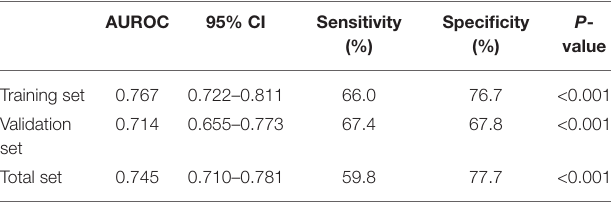
TABLE 4 | Performance of the model for identifying moderate to severe inflammation in the training set ( n = 430), validation set ( n = 290) and total set ( n = 720). TABLE 5 | AUROC of the other non-invasive models for identifying significant liver